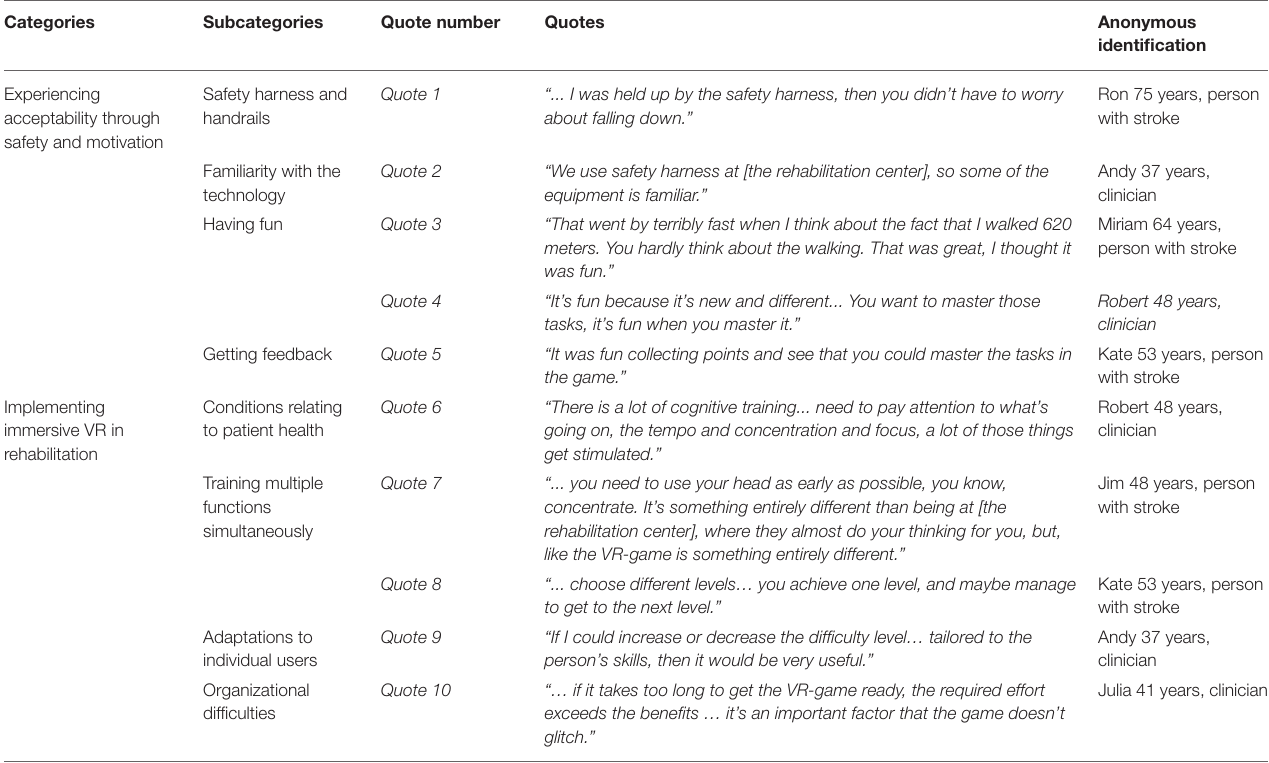
TABLE 2 | Quotes to exemplify the analytical